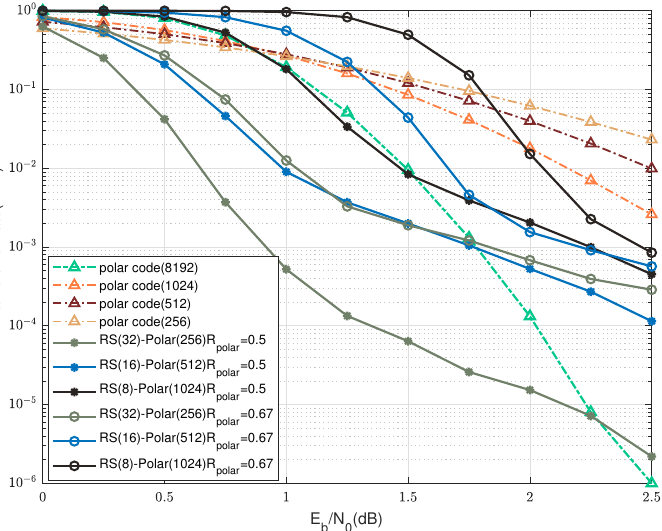
Figure 12. Comparison between the UEP-RS-polar product codes and the SC decoding of single polar codewords over GE channels for R tx ≈ 1/4, P GG = 0.99 and R polar = 0.5, 0.67.